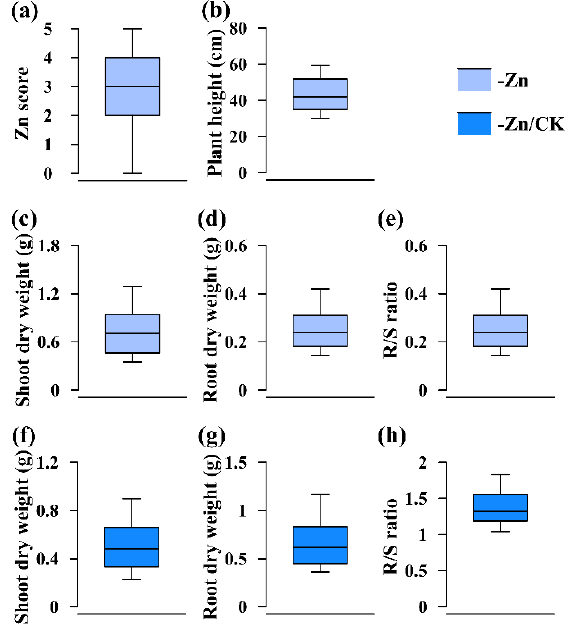
Figure 4. Phenotypic distribution of each trait in the K22×BY815 RIL population under different conditions (-Zn, -Zn/CK). ( a ) Zn score; ( b ) plant height; ( c , f ) shoot dry weight; ( d , g ) root dry weight; ( e , h ) R/S ratio. The solid line in each box represents the median values. The upper and bottom lines represent the 90th and 10th percentiles, respectively. The top and bottom edge of each box represent the 75th and 25th percentiles, respectively.